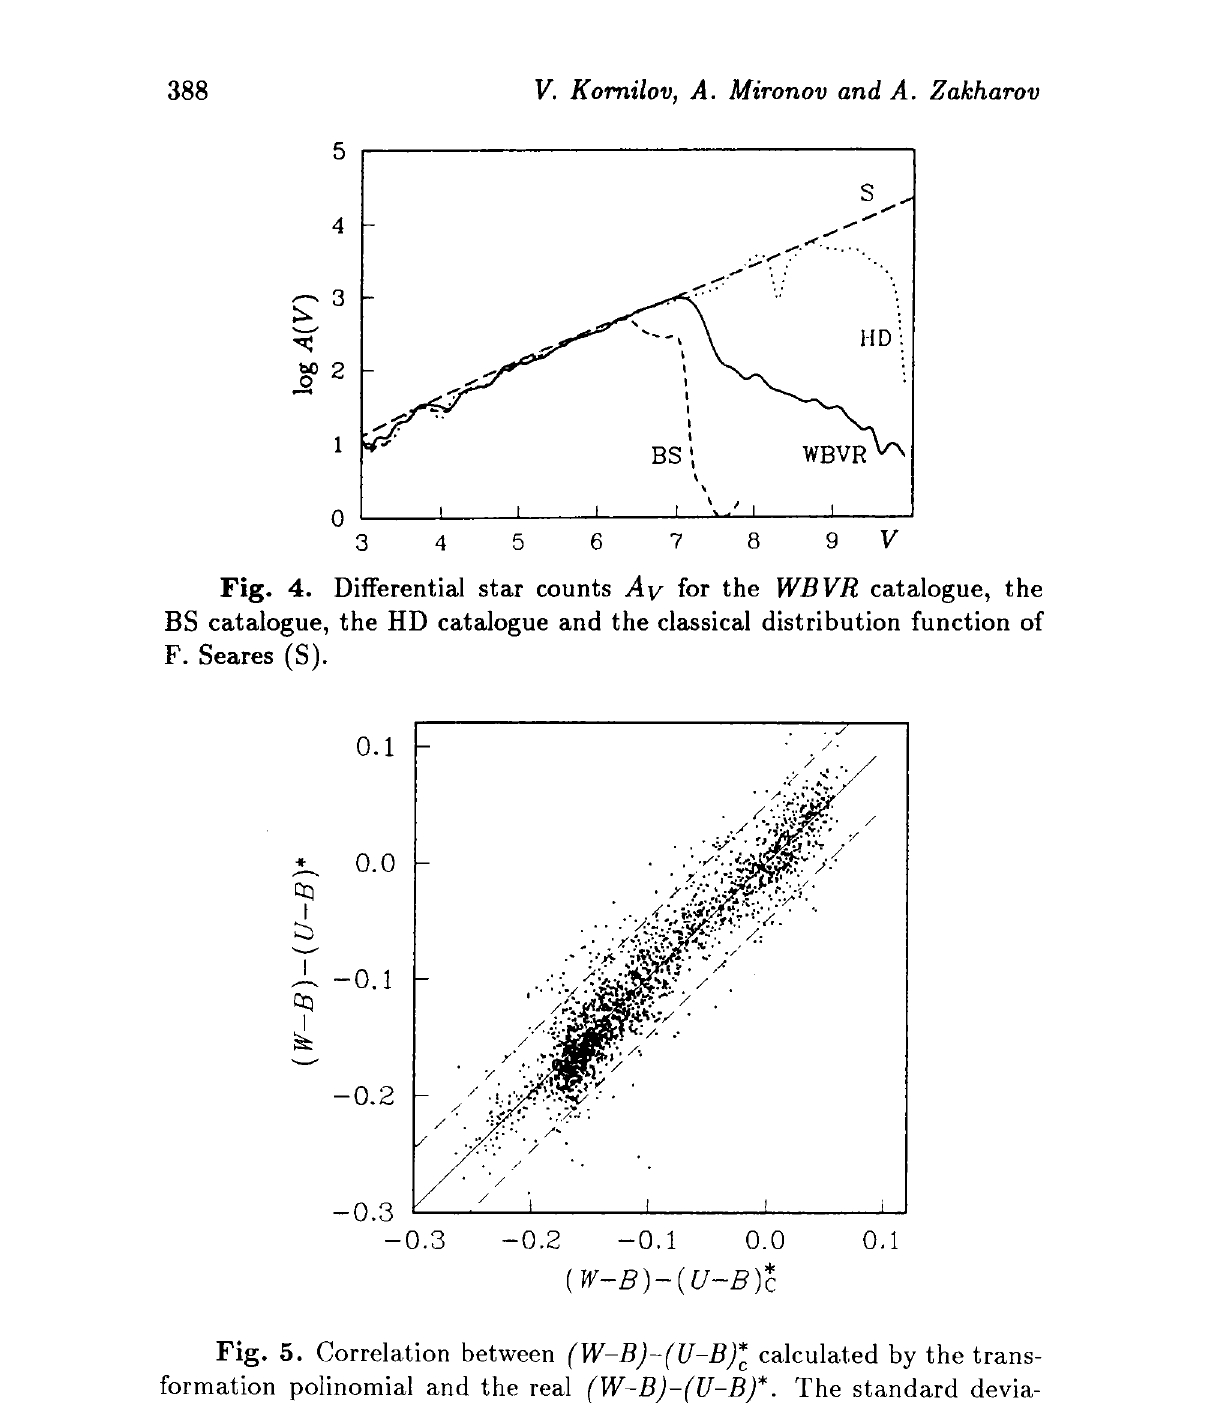
Fig. 5. Correlation between (W-B)-(U-B)* calculated by the trans- formation polinomial and the real (W-B)-(U-B)*. The standard devia- tion from the regression line is 0.026 mag. Dashed lines are 95 % bound- aries. The correlation coefficient is 0.94. Only a third of the stars are